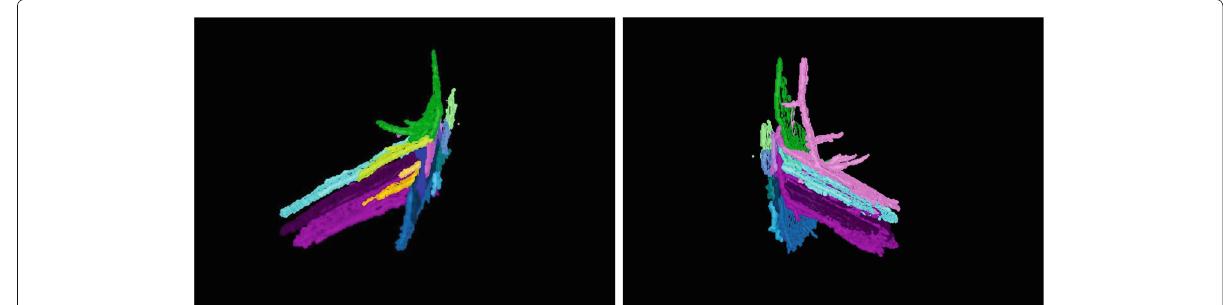
Fig. 6 Different views of the dendrite of the phase Al 11 La 3 in Al − La alloy. Different colors denote different connected components